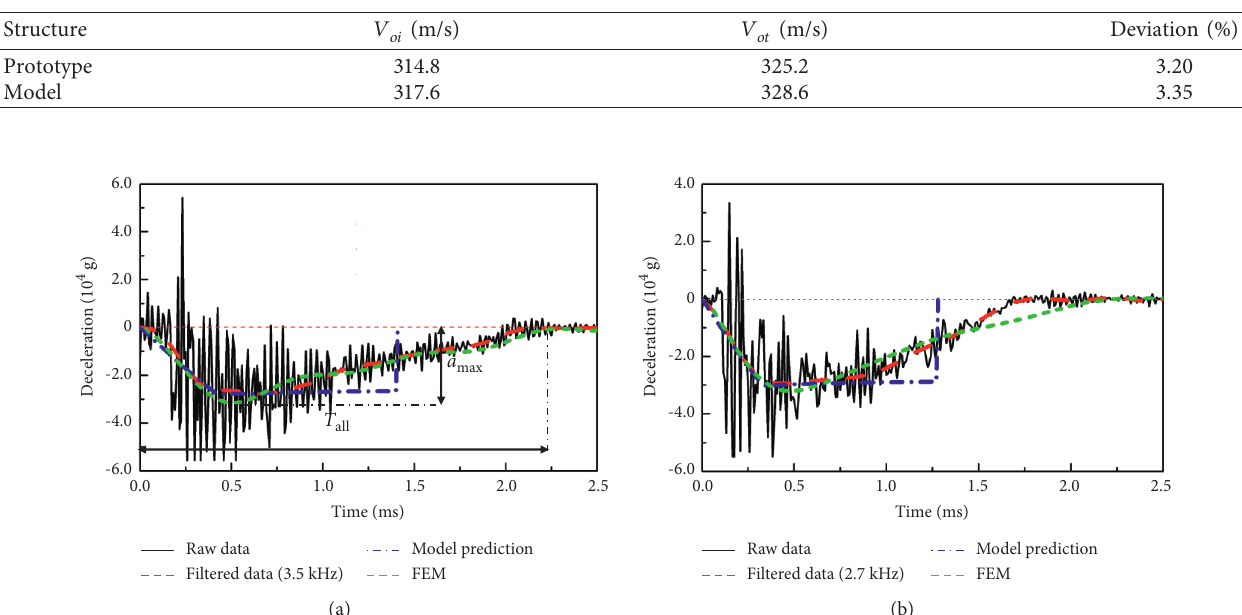
Figure 13: Comparison of the deceleration-time curves from test, simulation, and empirical model. (a) Prototype projectile; (b) non- proportional model.